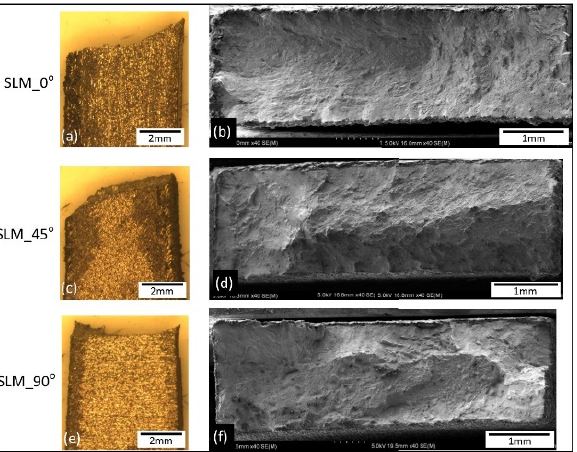
Figure 11. Macrographs showing side view of the tensile tested samples ( a , c , e ) and low magnification images of the fracture surfaces of the SLM samples ( b , d , f ).